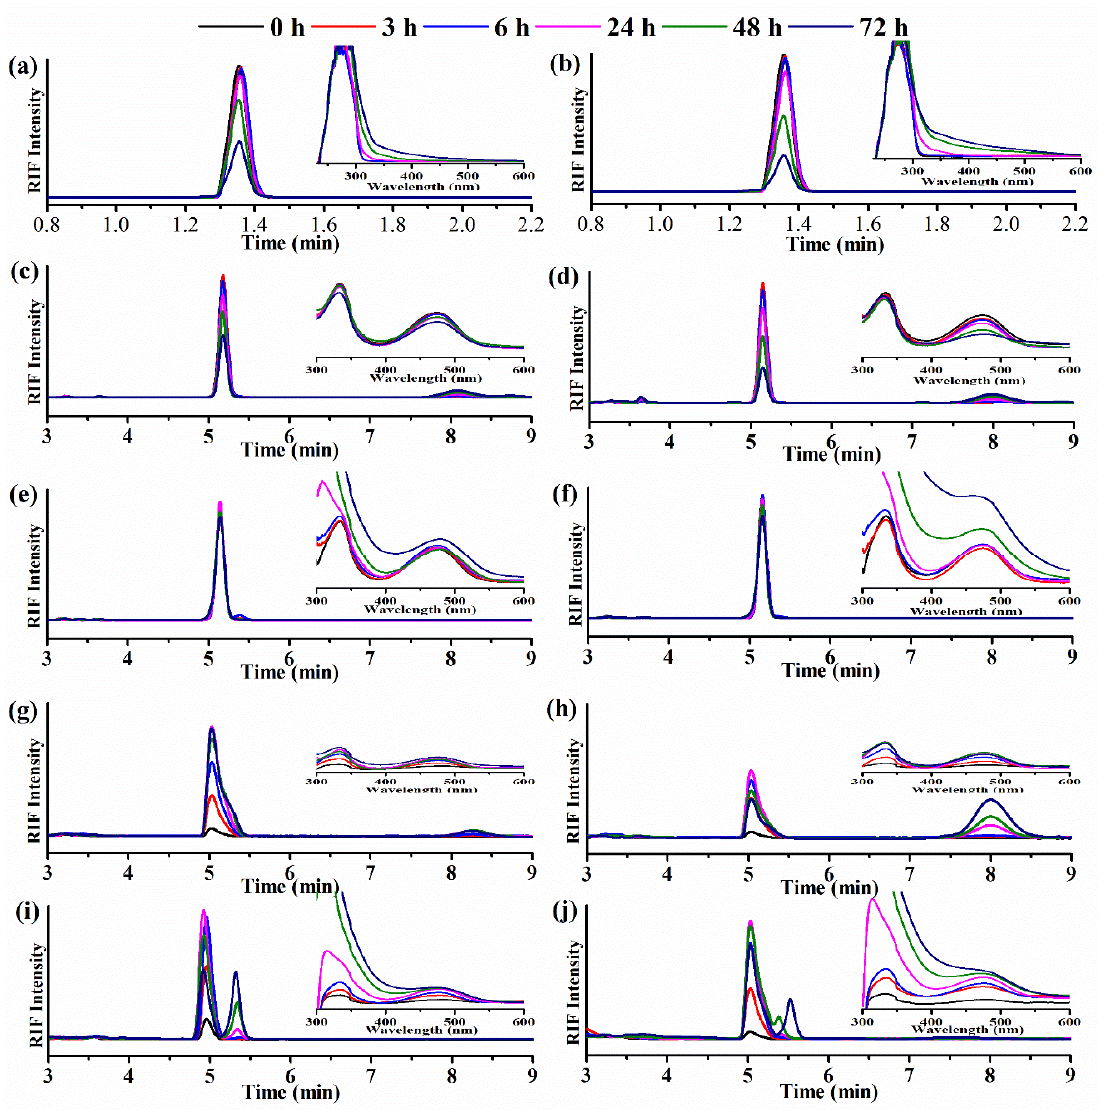
Figure 8. HPLC and UV/Vis spectra of ASC/pH 7.4 ( a ); ASC/pH 8.5 ( b ); RIF/pH 7.4 ( c ); RIF/pH 8.5 ( d ); RIF/ASC/pH 7.4 ( e ); RIF/ASC/pH 8.5 ( f ); RIF/APENs/pH 7.4 ( g ); RIF/APENs/pH 8.5 ( h ); RIF/APENs/ASC/pH7.4 ( i ); and RIF/APENs/ASC/pH 8.5 ( j ).